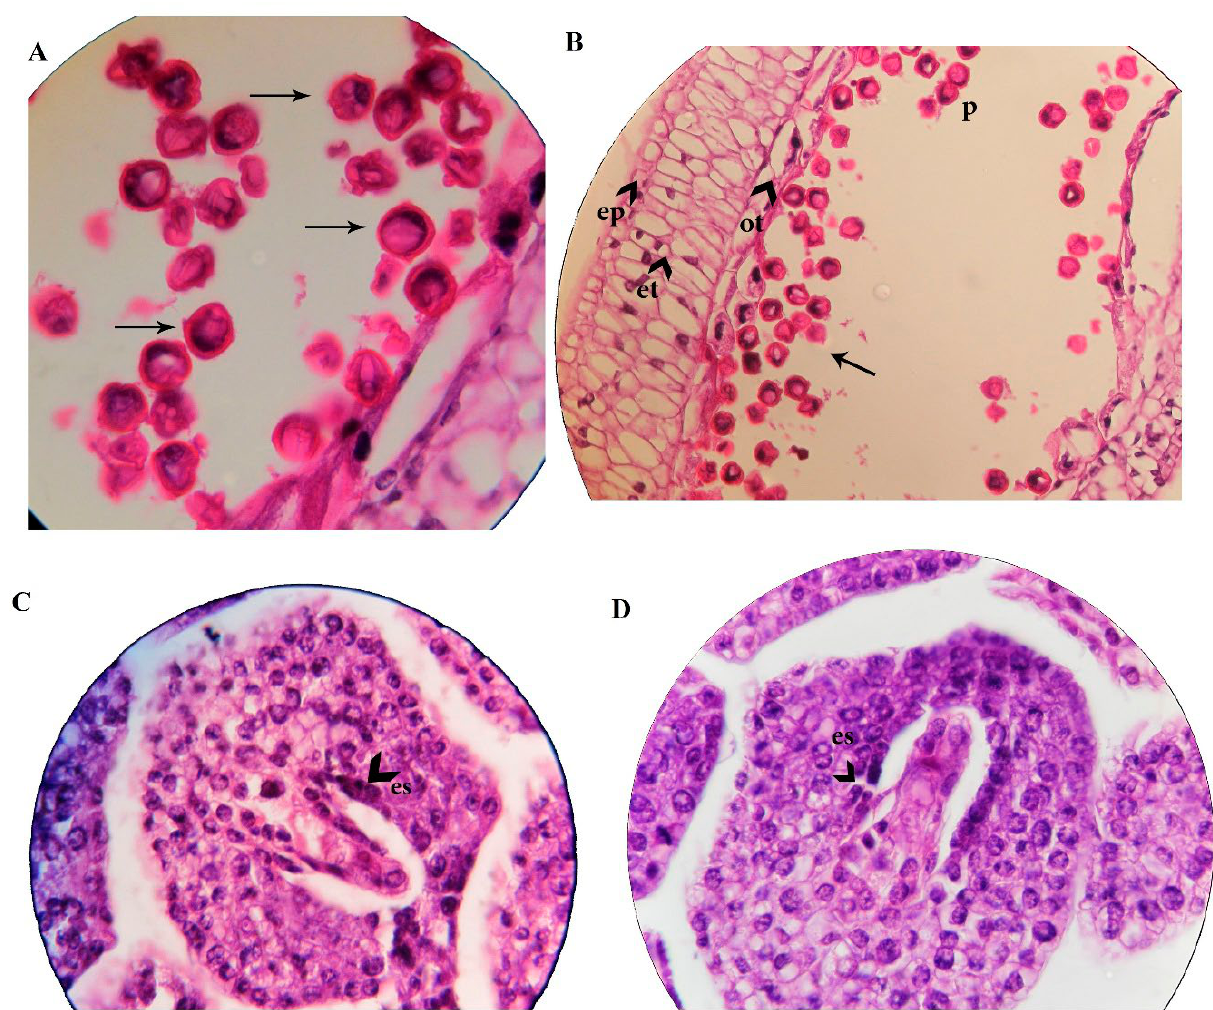
Figure 8. (A-B) Transverse sections of anther from treatment 1. abnormalities in pollen grains and collected black materials in pollen grain; (C-D) Transverse sections of ovule from treatment 1 . Change of the shape of embryo sac and also degradation of egg apparatus in plants (et – endothecium; ep – epidermis; es – embryo sac; ot – outer tapetum; p – pollen